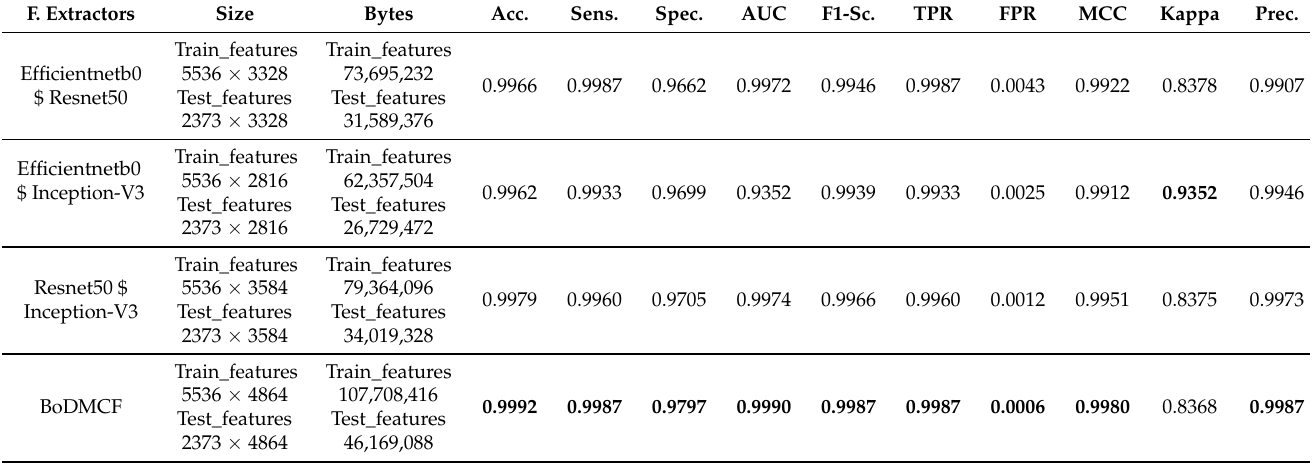
Table 11. Results of our proposed approach with features extracted from all four histopathological image magnifications (40 × , 100 × , 200, × and 400 × ) by three state-of-the-art CNN models (ResNet-50-, InceptionV3, and EfficientNet-b0). The effects of the number of features used on model performance are also shown. The 2- and 3-model combinations were based on best performing single model performance in Table 9. Accuracy achieved by prior breast cancer binary classification work are also shown in the bottom Table 12.